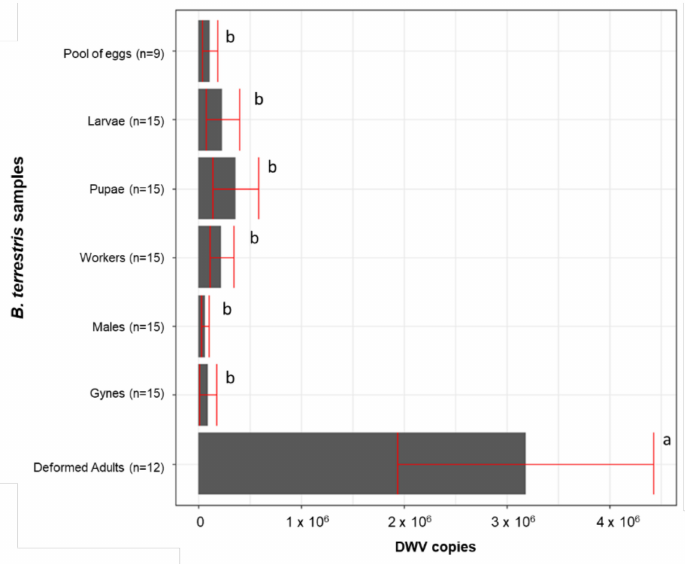
Figure 3. DWV titre of deformed and asymptomatic adults and juvenile individuals. Averages +/ − standard error are shown. The same letter indicates a nonsignificant